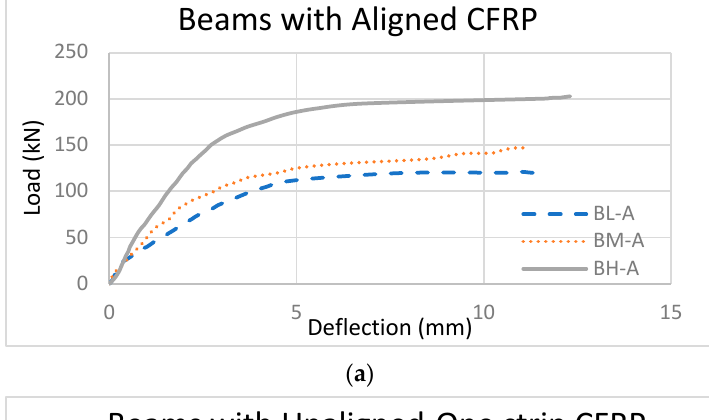
Table 4. Experimental and theoretical capacity results.